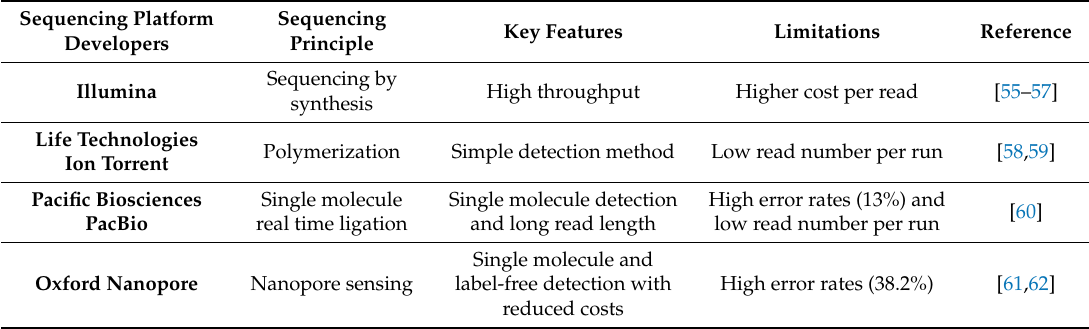
Table 2. Comparison of characteristics of the main next-generation sequencing